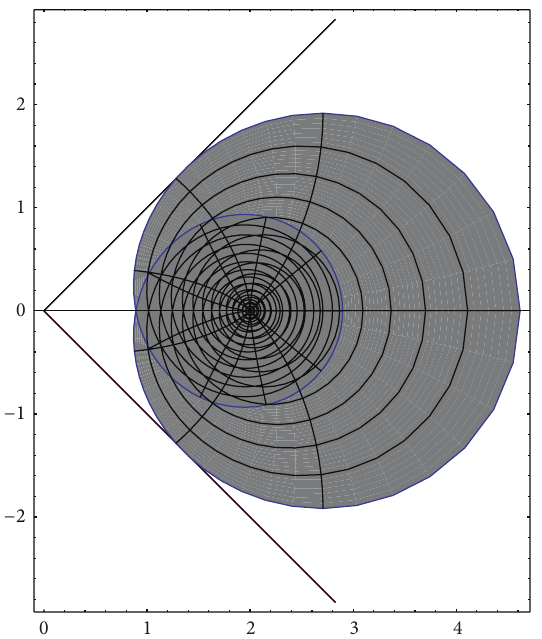
Figure 10: Image of |𝑧| ≤